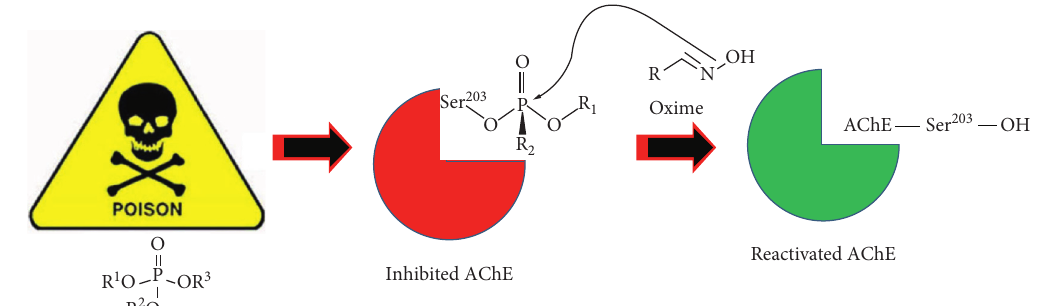
Figure 3: General mechanism of nucleophilic attack from the oxime reactivator towards OP.